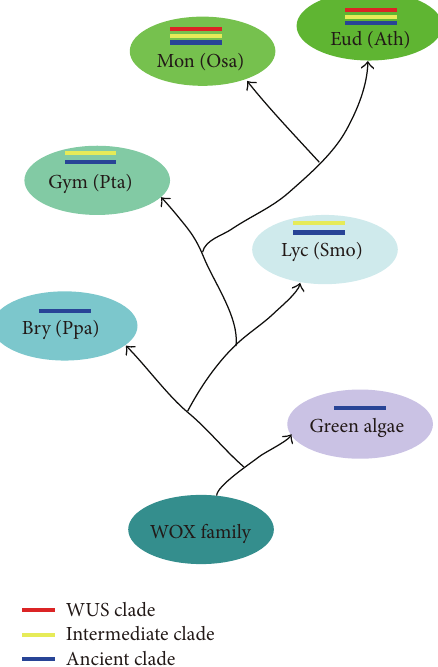
Figure9:AproposedmodeloftheevolutionaryhistoryofplantWOXfamily.Theschematictreerepresentstheproposedevolutionaryhistory of WOX family. Different color represents different clade. The WOX family might originate from green algae and expand in Lycopodiophyta with the appearance of the intermediate clade, and along with the emergence of seed plants, the WOX family generated WUS clade from the intermediate clade. Bry: Bryophyta, Lyc: Lycopodiophyta, Gym: Gymnosperm, Mon: Monocots, Eud: Eudicots, Ppa: Physcomitrella patens , Smo: Selaginella moellendorffii , Pta: Pinus taeda , Osa: Oryza sativa , and Ath: Arabidopsis thaliana .